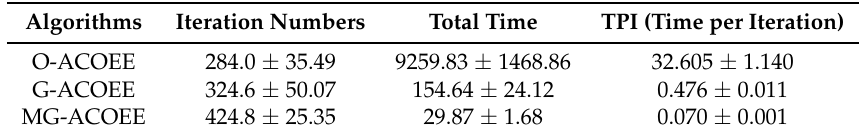
Table 6. Comparison of O-ACOEE, G-ACOEE, and MG-ACOEE (ASC) on computing performance for Cuprite data.